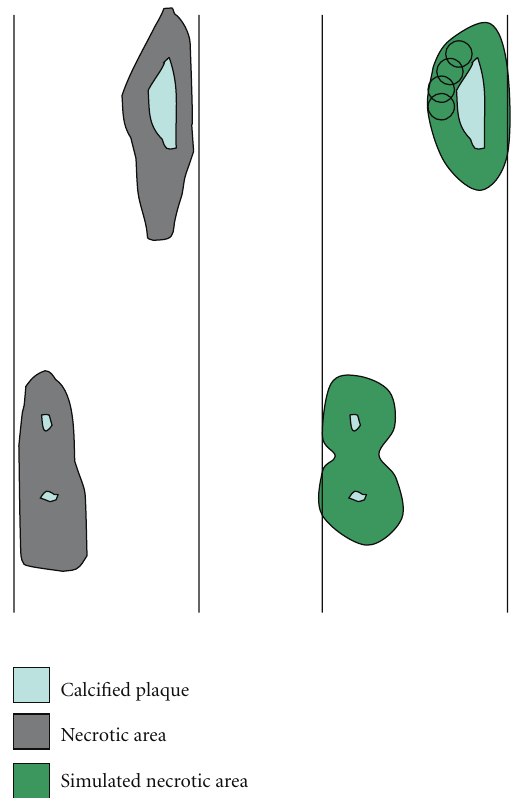
Figure 3: Left: a schematic visualization of a plaque similar to what can be seen in histology. The calcified plaque (light blue) is surrounded by an area of necrotic tissue (gray). Right: the simulated area tries to imitate the area of necrotic tissue (green) as seen in histology by a morphological dilation (visualized by circles) of the calcified plaque (light